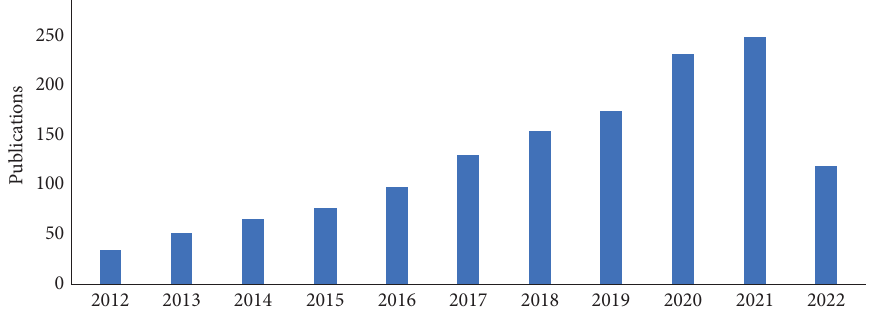
Figure 1: Bar chart of the number of annual papers